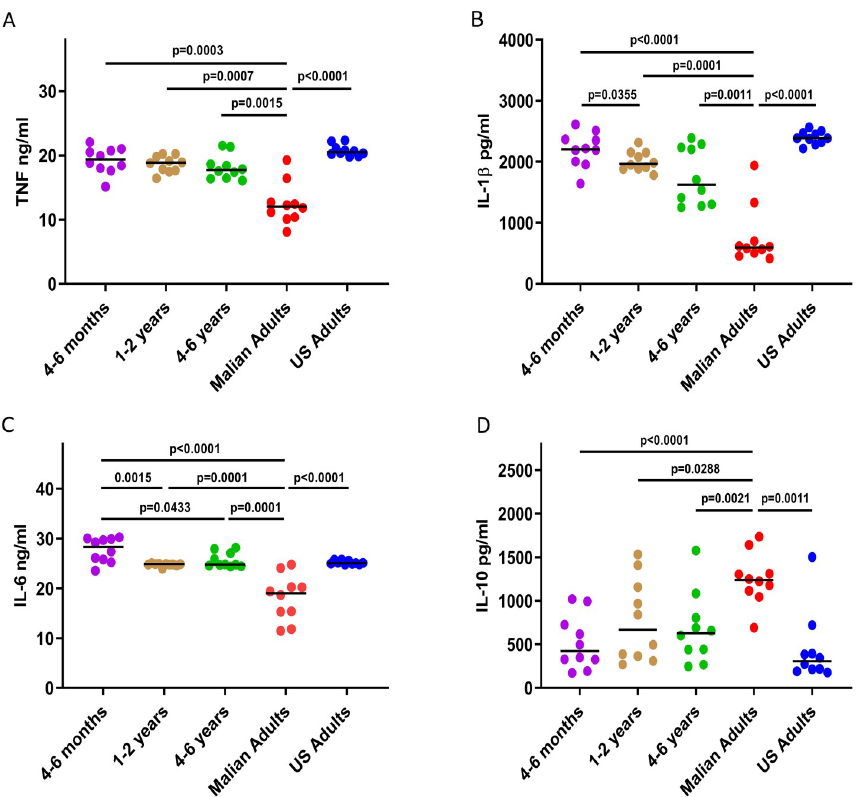
Fig 1. Monocytes of Malian adults exhibit reduced P . falciparum -inducible inflammatory cytokine production and increased IL-10 production. PBMCs were collected cross-sectionally from an age-stratified cohort in Mali before the malaria season when all subjects were negative for Pf infection by PCR; and also, from malaria-na ï ve U.S. adults. Monocytes were isolated from thawed PBMCs and stimulated with Pf-iRBC lysate at a ratio of 1 monocyte to 30 iRBCs. After 24 hours, cell culture supernatants were analyzed to quantify secreted ( A ) TNF, ( B ) IL-1 β , ( C ) IL-6 and ( D ) IL-10. Median values are indicated by a horizontal line. P-values are from pairwise Mann-Whitney tests with a Bonferroni adjustment for all 10 pairwise comparisons. Nonsignificant p-values are not shown.